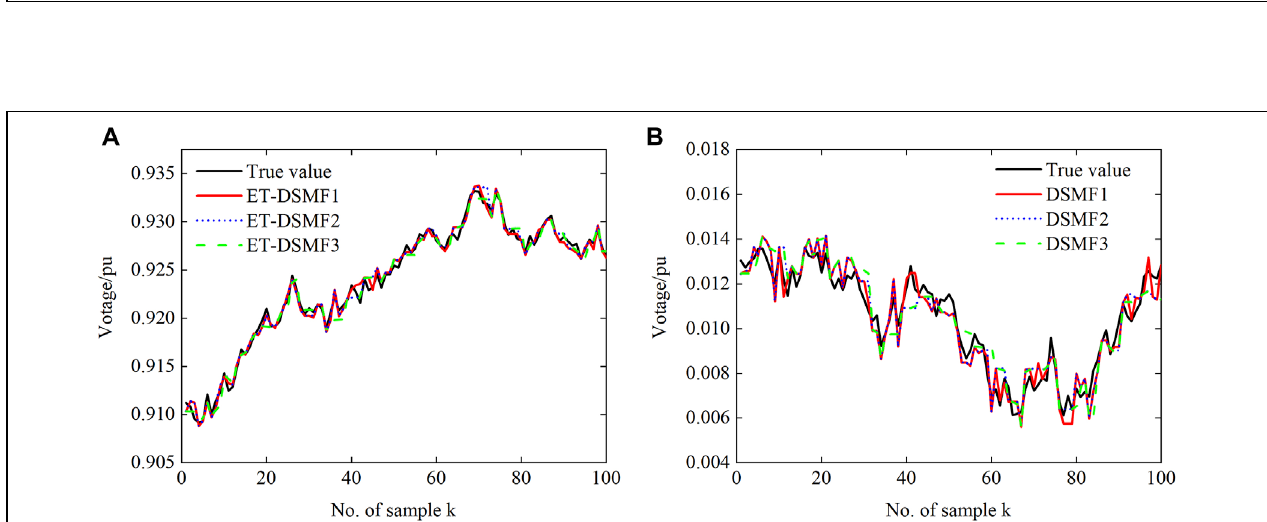
Frontiers in Energy Research |